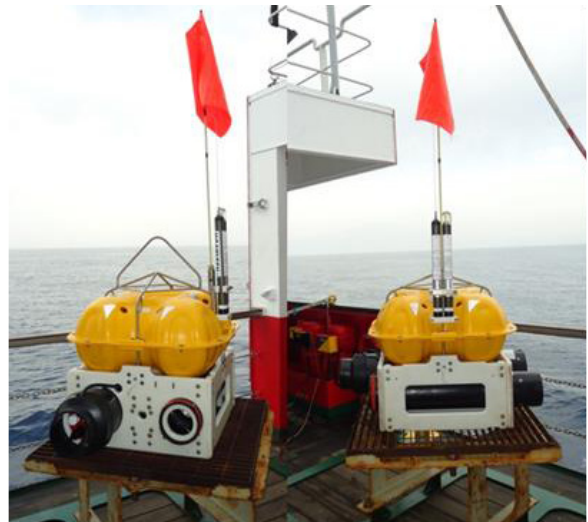
Figure 5. Spanish OBS.